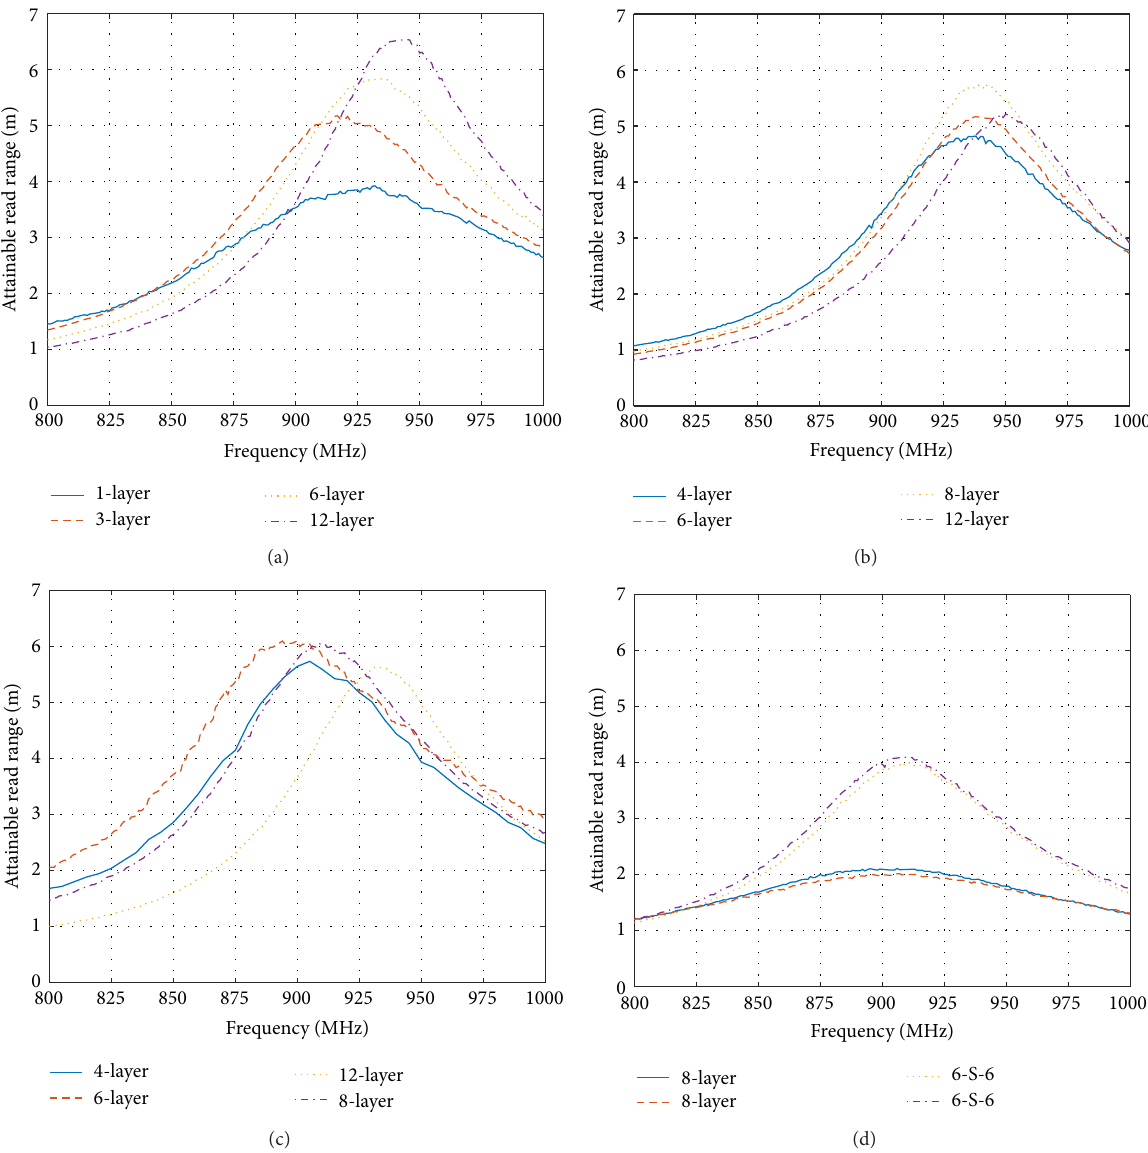
Figure 6: The measured read ranges of all tags: (a) the read ranges of tags on Paper B, (b) the read ranges of tags on Paper C, (c) the read ranges of tags on Cardboard A, and (d) the read ranges of tags on Cardboard